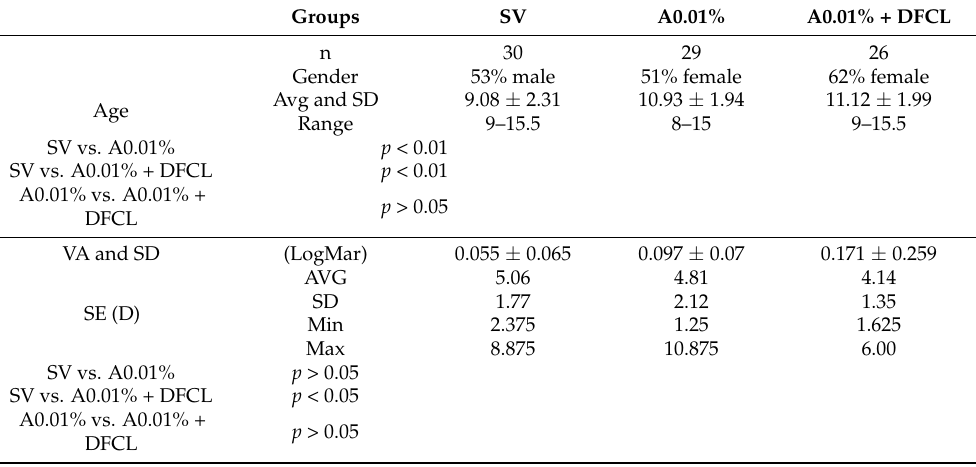
Table 1. Children demographics. SV: single-vision spectacle lenses (control group). A0.01: 0.01% atropine for two years of treatment. A0.01% + DFCL: contact lenses with dual focus and topical 0.01% atropine for two years. VA = visual acuity; SD = standard deviation; SE = spherical equivalent.